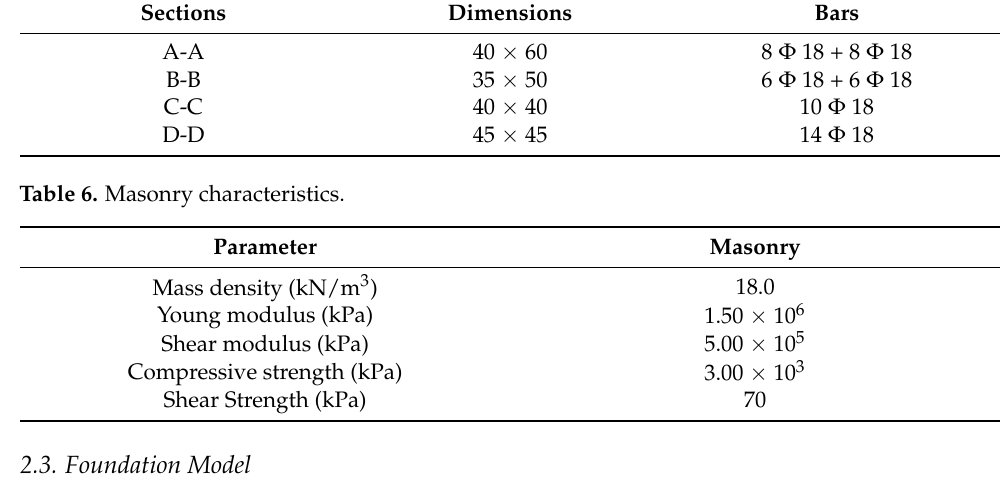
Table 5. Structural elements characteristics.